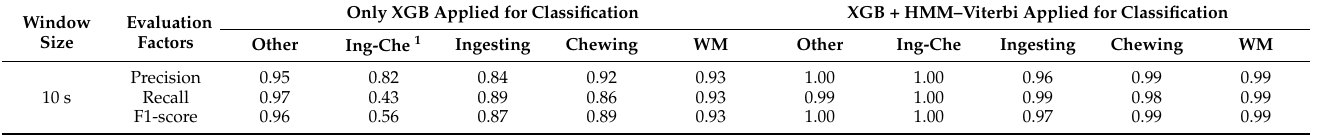
Table 3. Evaluation of the developed mode for activity classification before and after applying the correction of the HMM–Viterbi algorithm when accelerometer signals were sampled at the position of P1.